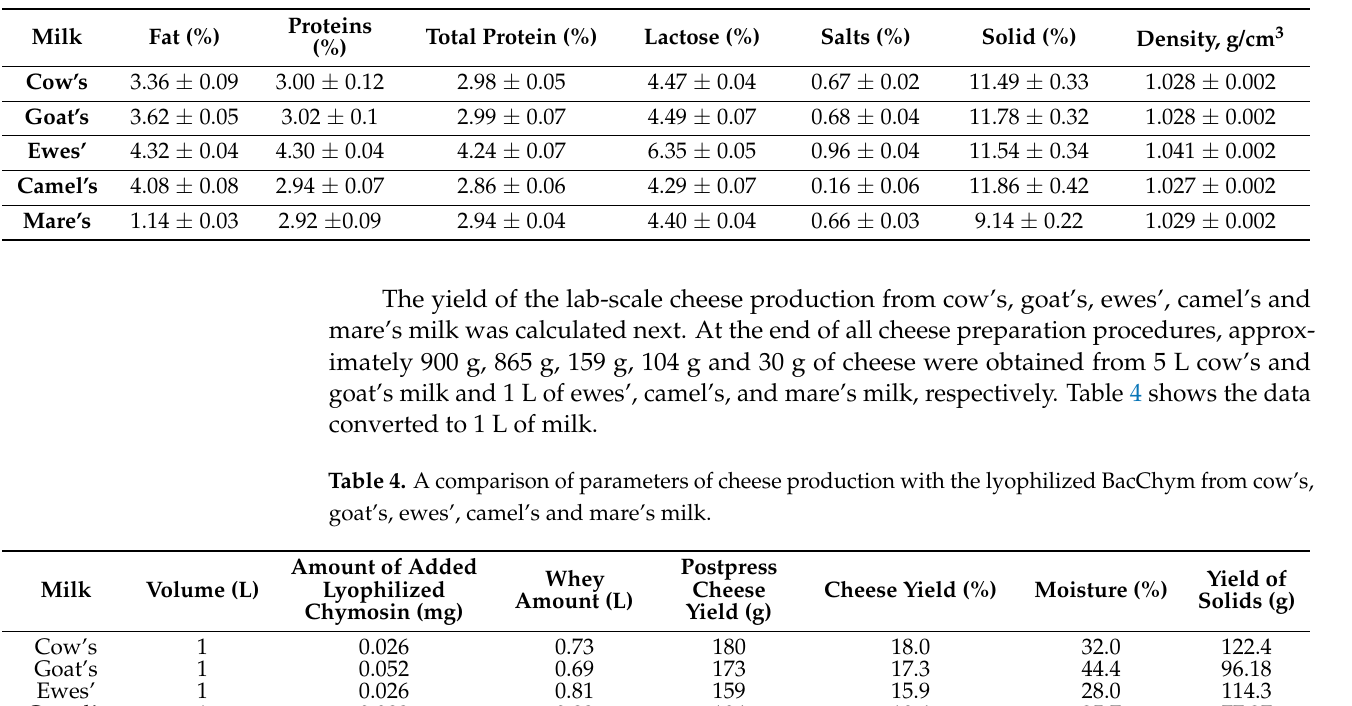
Table 3. Indicators of cow’s, goat’s, ewes’, camel’s and mare’s milk.